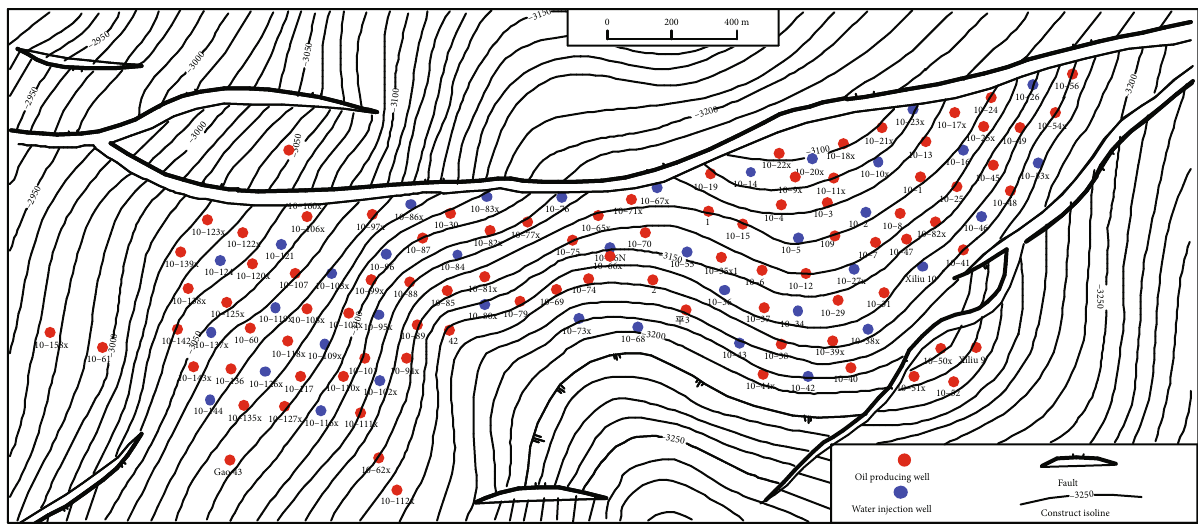
Figure 2: Structural map of the top surface of the Es